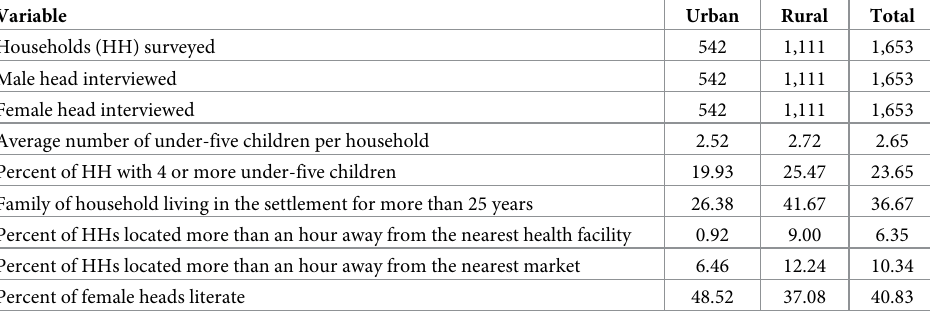
Table 1. Descriptive characteristics of the surveyed households in northern